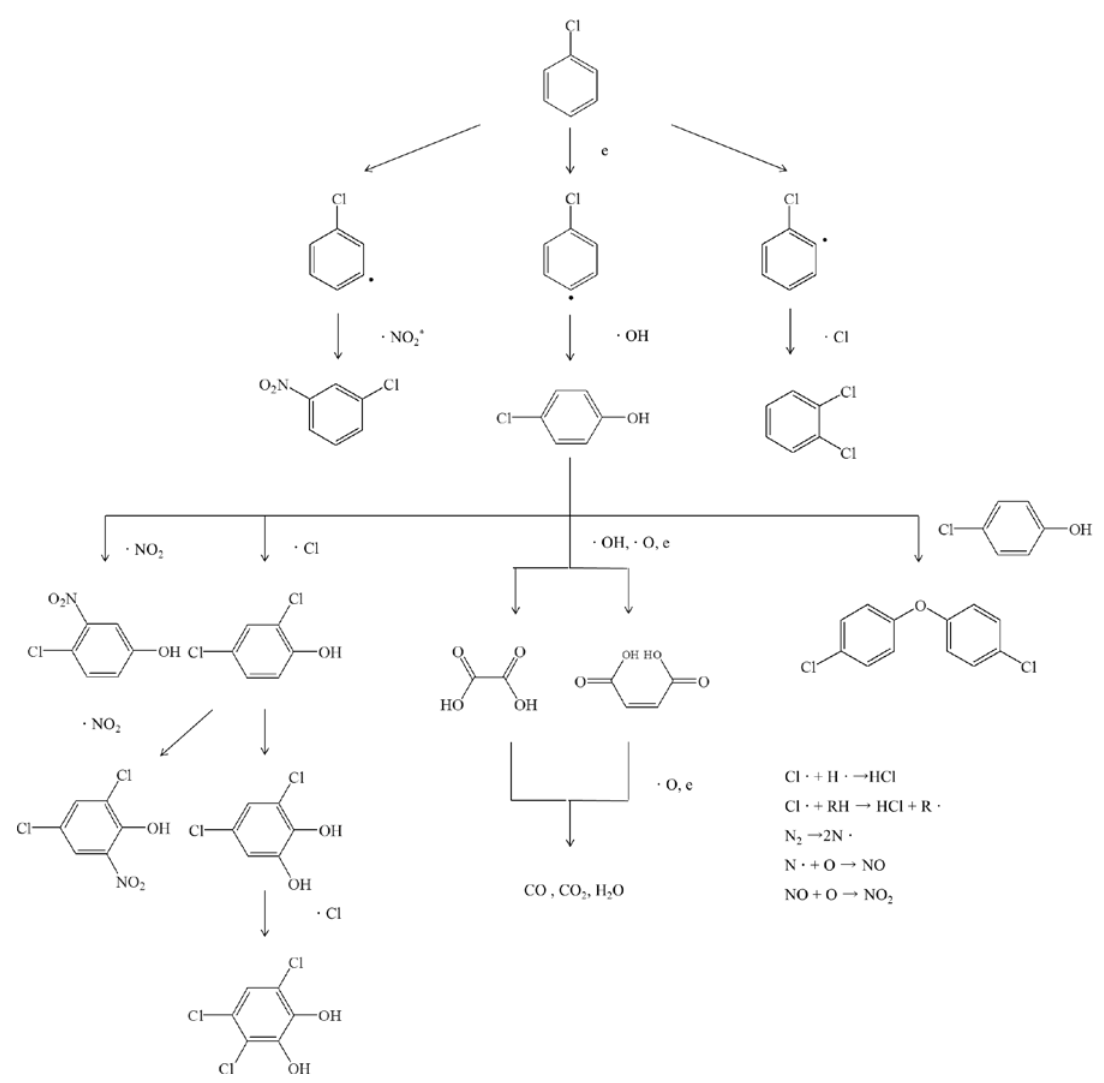
Figure 11. A speculative decomposition mechanism of chlorobenzene by DBD. *: The R · refers to the free radicals generated by the DBD discharge.